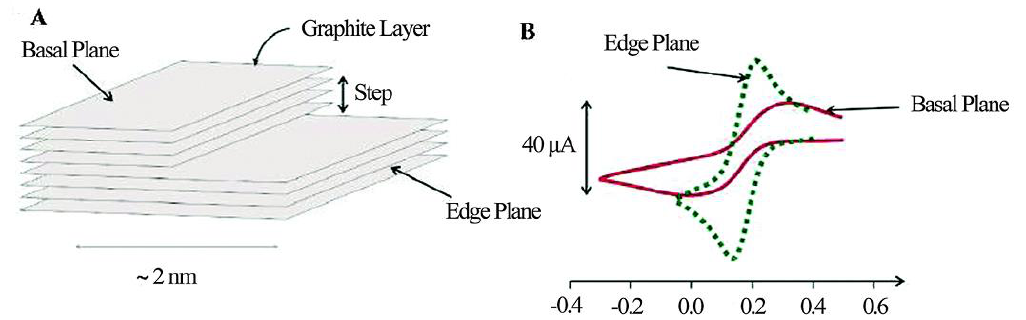
Figure 4. Illustration of edge and basal plane sites on carbon materials and their different electrochemical response ( Reproduced by permission from American Chemical Society from Ref.